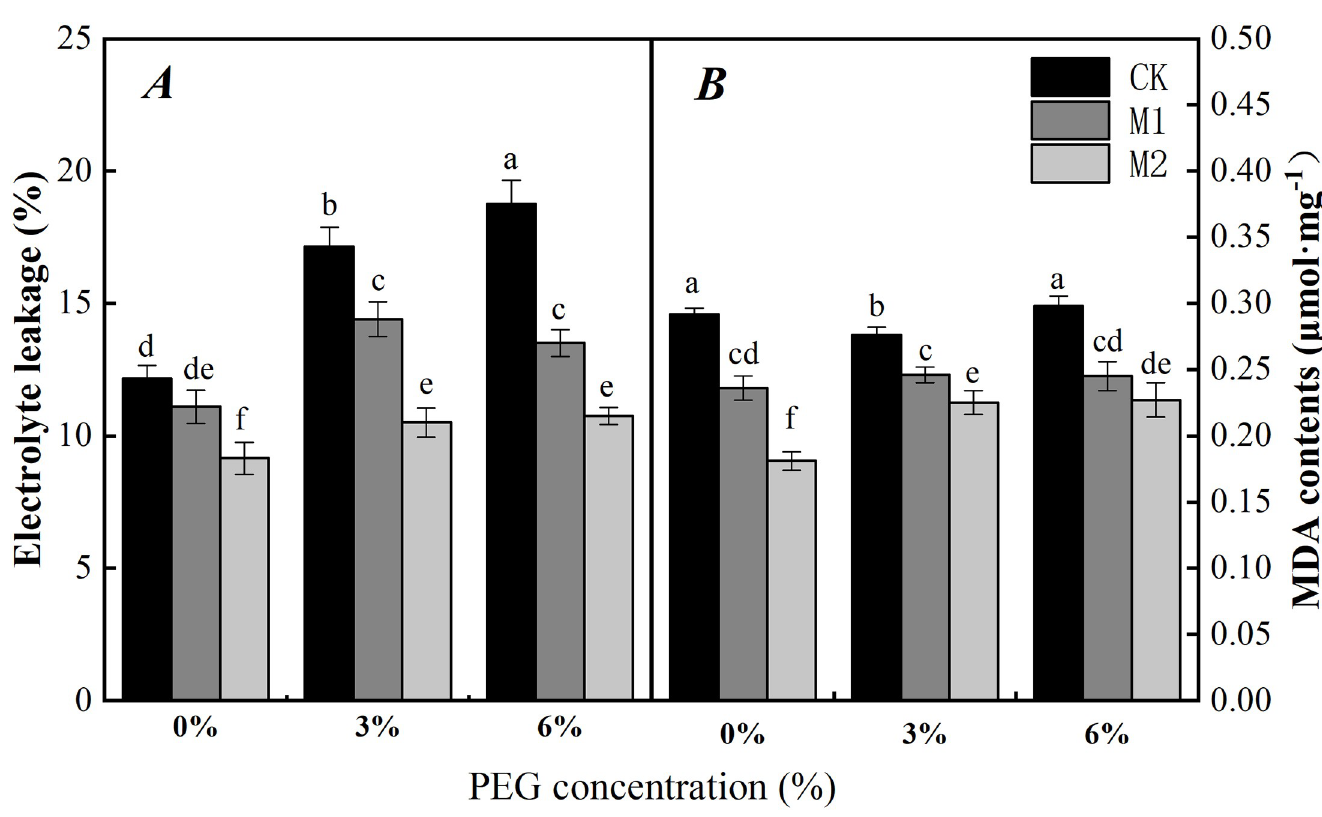
Fig 6. Effect of soaking with melatonin on EL (A) and MDA (B) of soybean radicle under PEG stress. 0%, 3% and 6% were indicated 0%, 3% and 6% PEG6000 ( w/ v ). Values are the means of three replicates ± S.E. Bars with different letters are significantly different at P � 0.05.